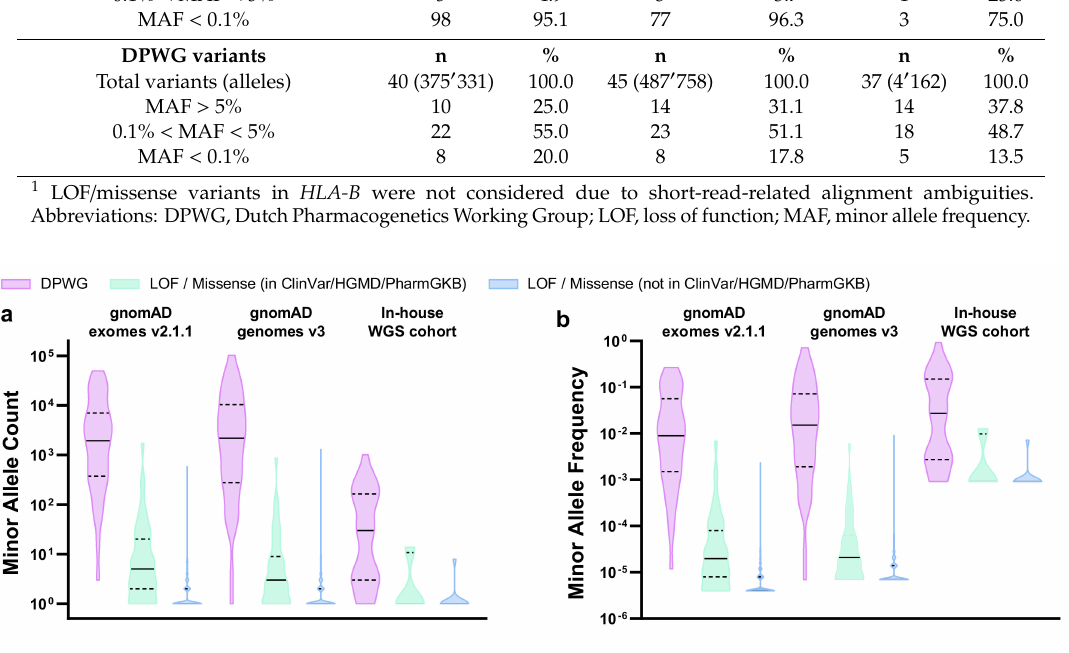
Figure 2. Violin plots showing the distributions of ( a ) minor allele counts and ( b ) minor allele frequencies in 11 DPWG genes ( CYP2B6 , CYP2C9 , CYP2C19 , CYP2D6 , CYP3A5 , DPYD , F5 , SLCO1B1 , TPMT , UGT1A1 , VKORC1) and an HLA-B*5701 tagging variant in gnomAD exomes v2.1.1, gnomAD genomes v3, and our in-house WGS cohort. Horizontal lines indicate median, horizontal dashed lines indicate quartiles. Plots were generated using Graphpad Prism 8 (Graphpad Software, CA,